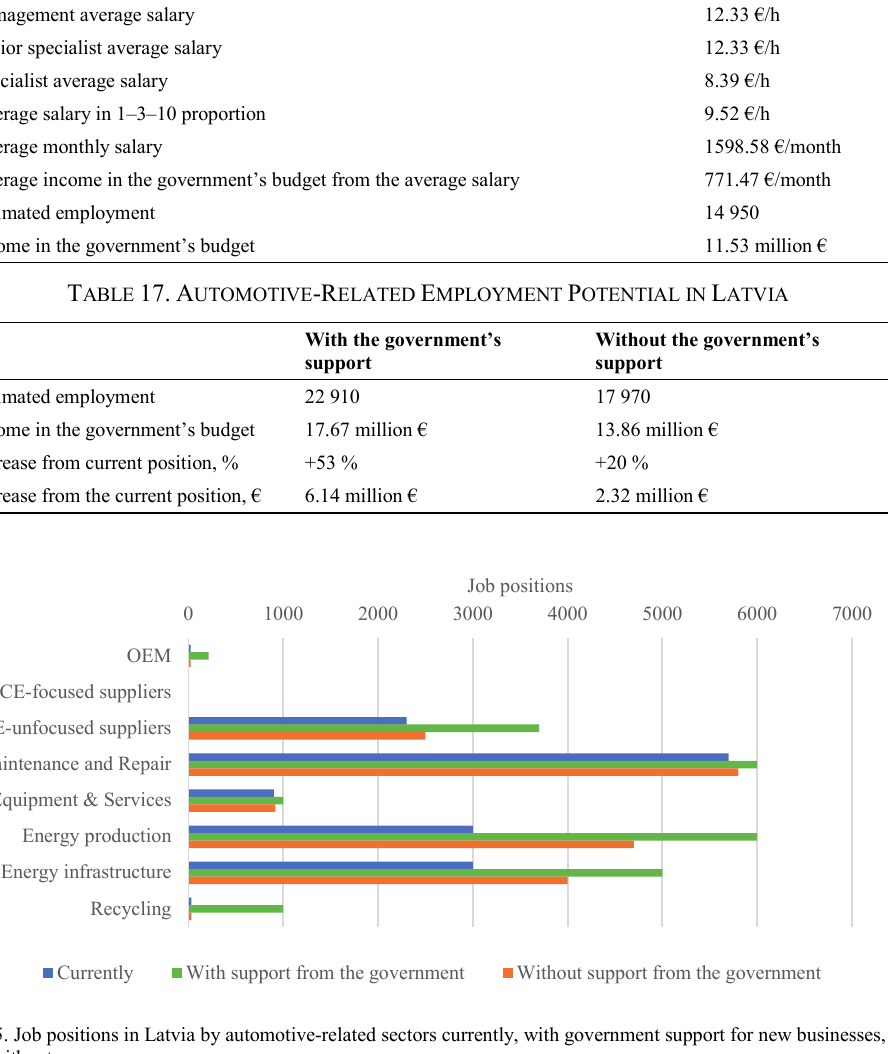
Fig. 5. Job positions in Latvia by automotive-related sectors currently, with government support for new businesses, and without. Since Latvia does not have any major ICEV focused manufacturing the overall job position count increase is expected in both scenarios. However, job positions are more threatened by other factors like